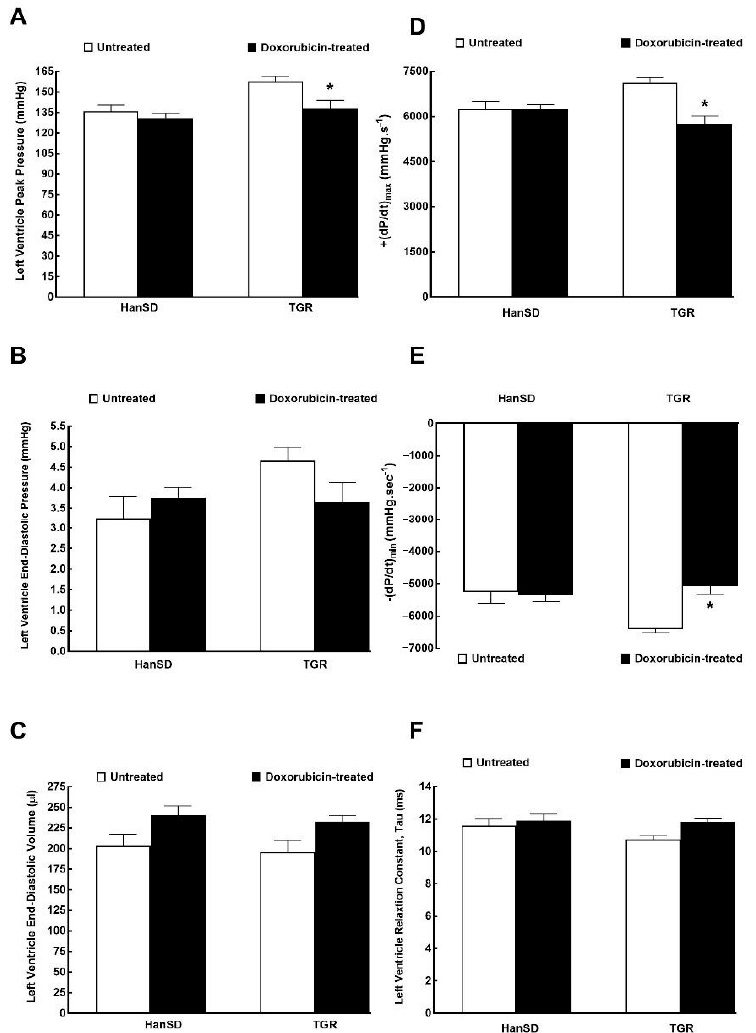
Figure 5. The first data part of the left ventricular cardiac function assessment by invasive hemodynamic analysis performed two weeks after the last doxorubicin injection (i.e., at the end of the experimental protocol) in normotensive, transgene-negative Hannover Sprague-Dawley (HanSD) and hypertensive, Ren-2 transgenic (TGR) rats. Left ventricle peak pressure ( A ), left ventricle end-diastolic pressure ( B ), left ventricle end-diastolic volume ( C ), maximum rates of pressure rise ( + dP / dt) max ( D ), maximum rates of pressure fall ( − dP / dt) max ( E ), relaxation constant tau ( F ). * p < 0.05 compared with untreated animals of the same strain. The values are means ±